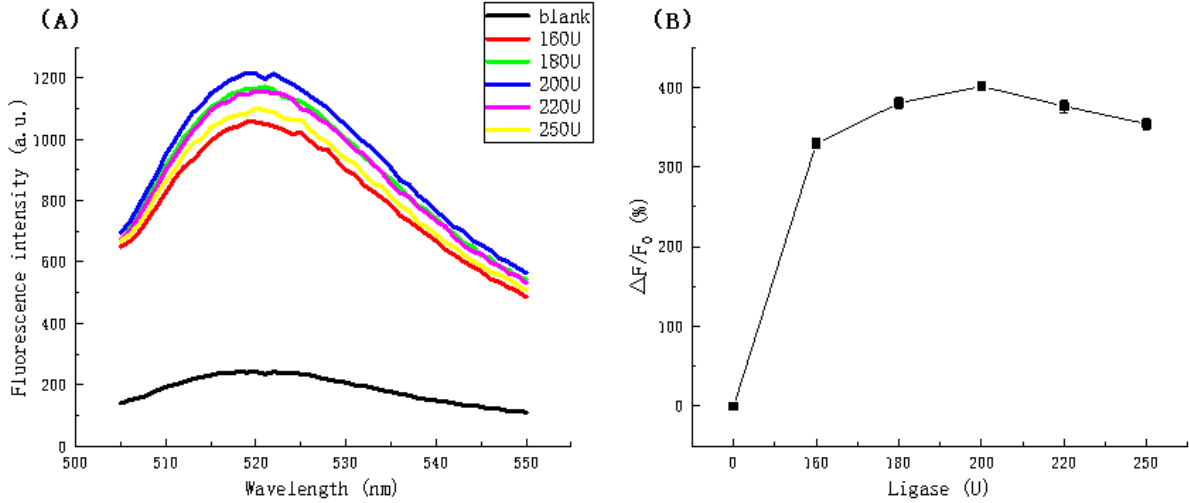
Figure 4. ( A ) Fluorescence spectra and ( B ) Fluorescence intensity ratio ( △ F / F 0 ) in the presence of different ligase dosages.